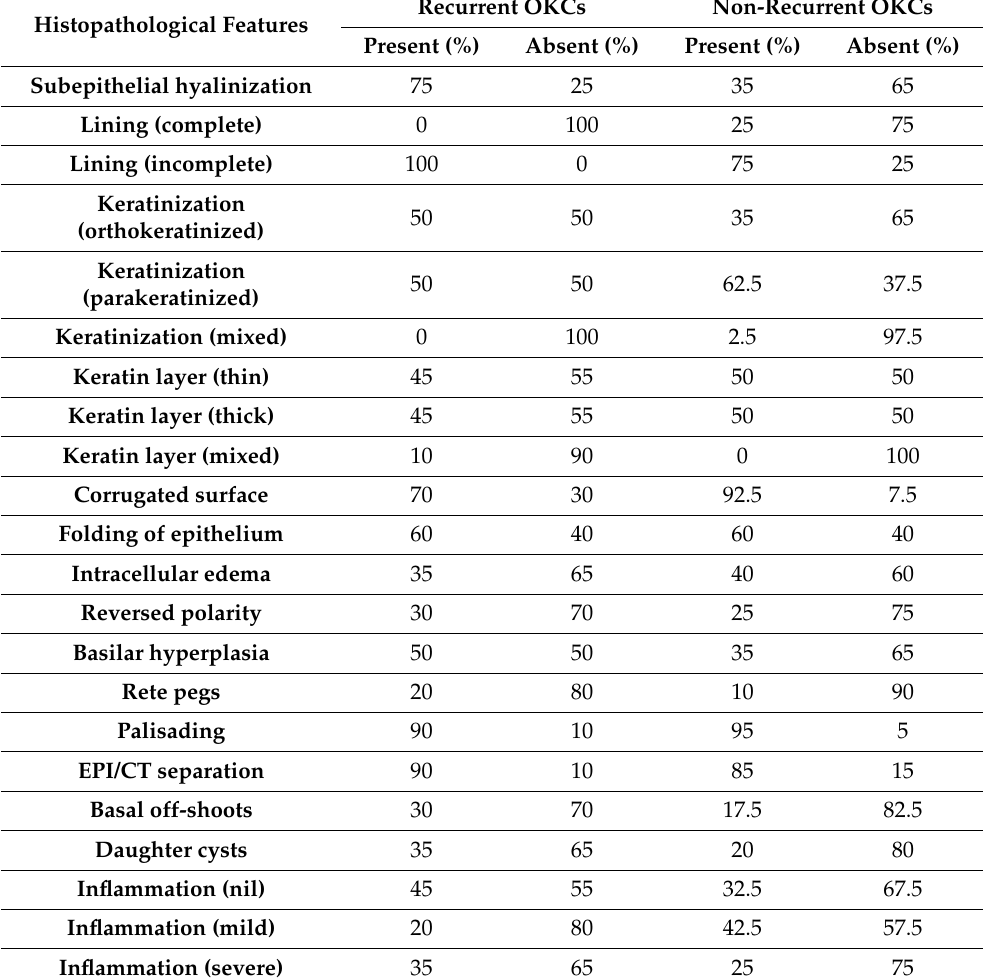
Table 1. Histopathological features noted in recurrent and non-recurrent OKCs.